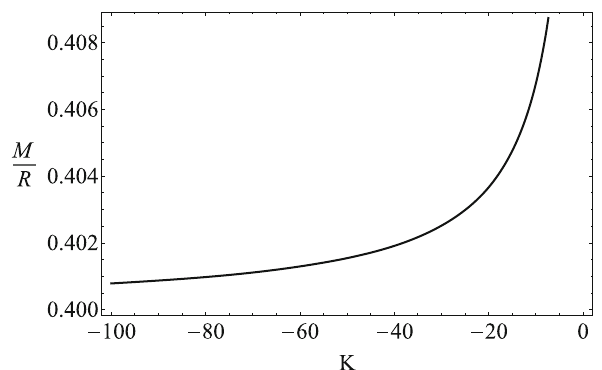
Fig. 1 Upper bound on M / R plotted against the anisotropic parameter K